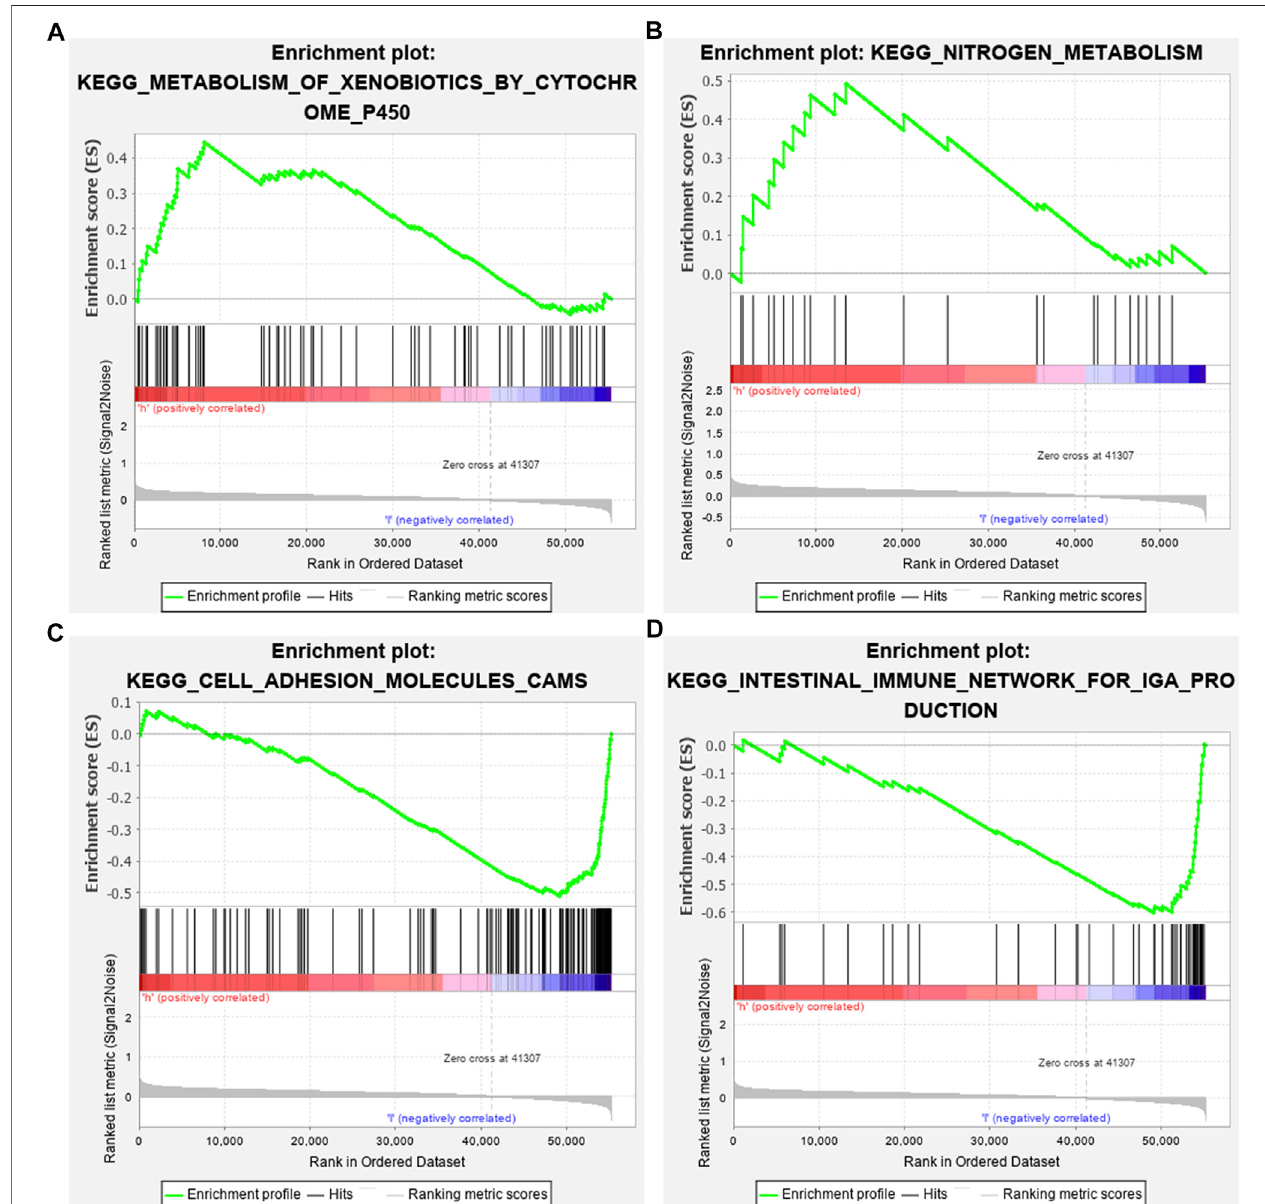
FIGURE 6 | Identifying involved signaling pathways. (A) Metabolism of xenobiotics by cytochrome P450; (B) nitrogen metabolism; (C) cell adhesion molecules cams; and (D) intestinal immune network for IgA production.